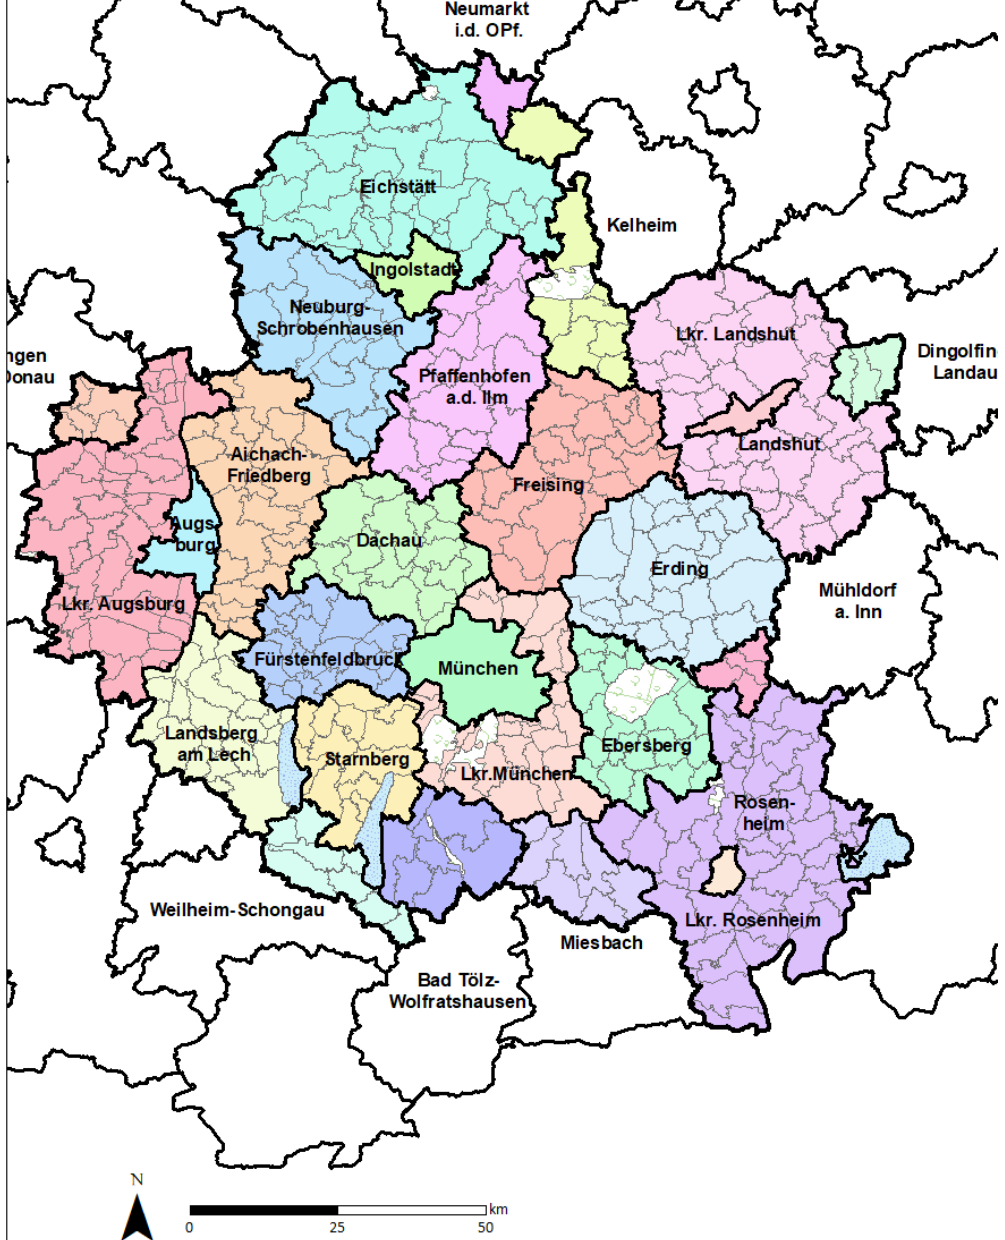
Figure 1. Greater Munich metropolitan area: counties and municipalities.